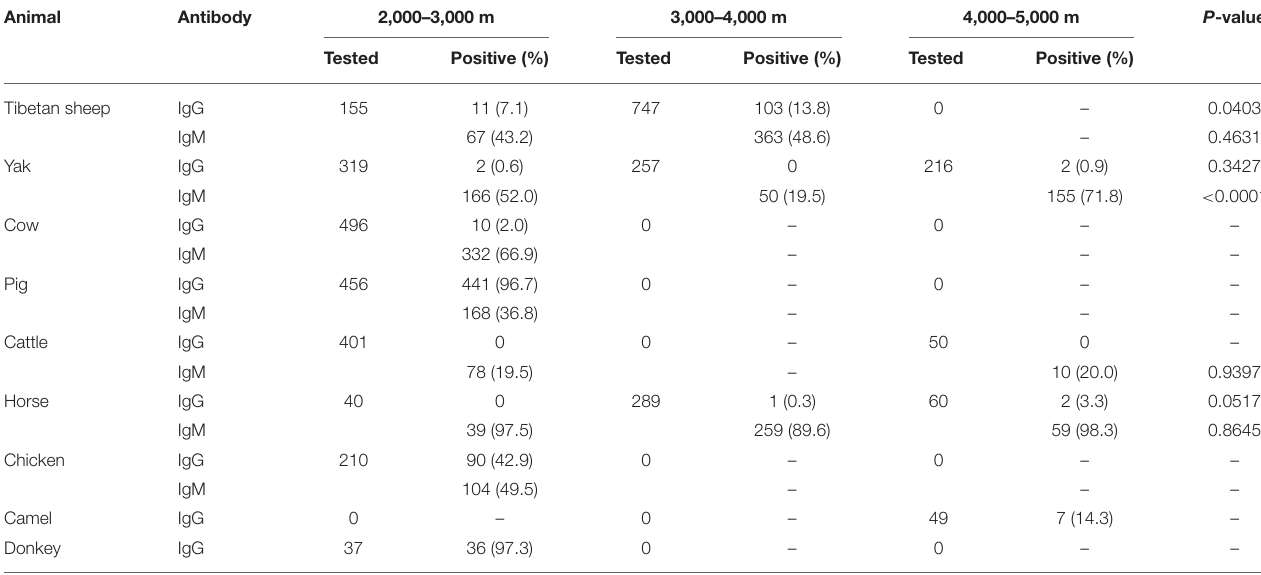
TABLE 4 | Analysis of the influence of altitude on the seroprevalence of the Neospora caninum IgG and IgM antibodies and distribution of toxoplasmosis and neosporosis in the QTPA.